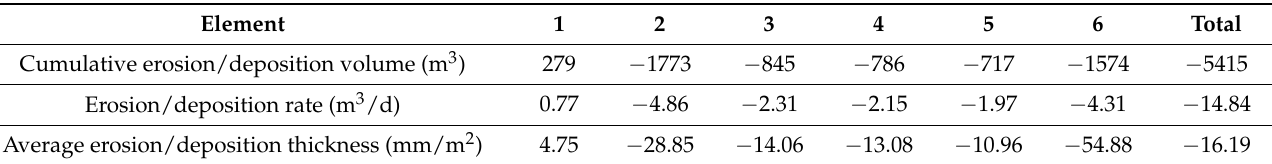
Figure 13. ( a ) 6 elements and the transport of ( b ) beach berm sediment, ( c ) sandbar sediment, and ( d ) background sediment one year after the beach nourishment. Transport volume less than 0.1 m 3 is not marked in the figure. Table 2. The cumulative erosion/deposition volume, erosion/deposition rate and average erosion/deposition thickness per unit area of the 6 elements one year after the beach